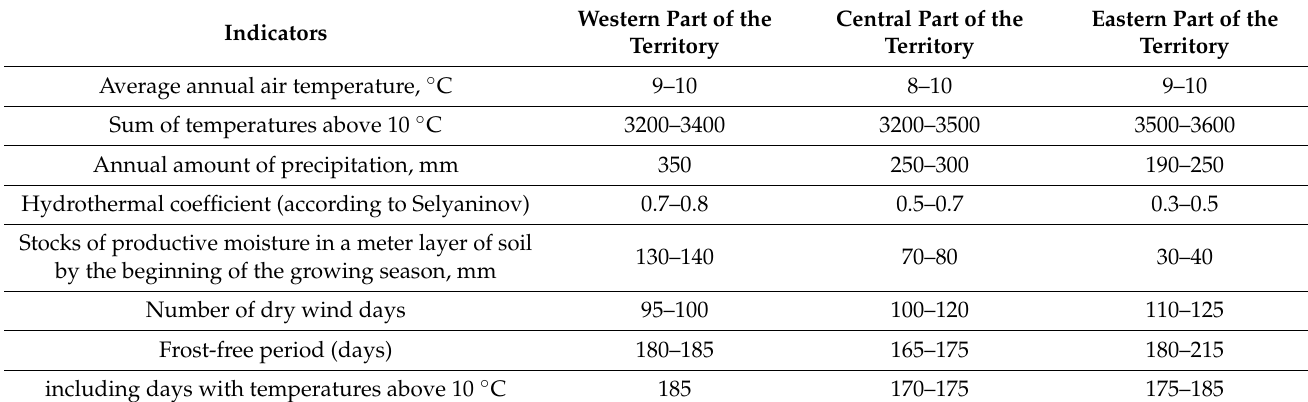
Table 1. Meteorological conditions of the Republic of Kalmykia in south